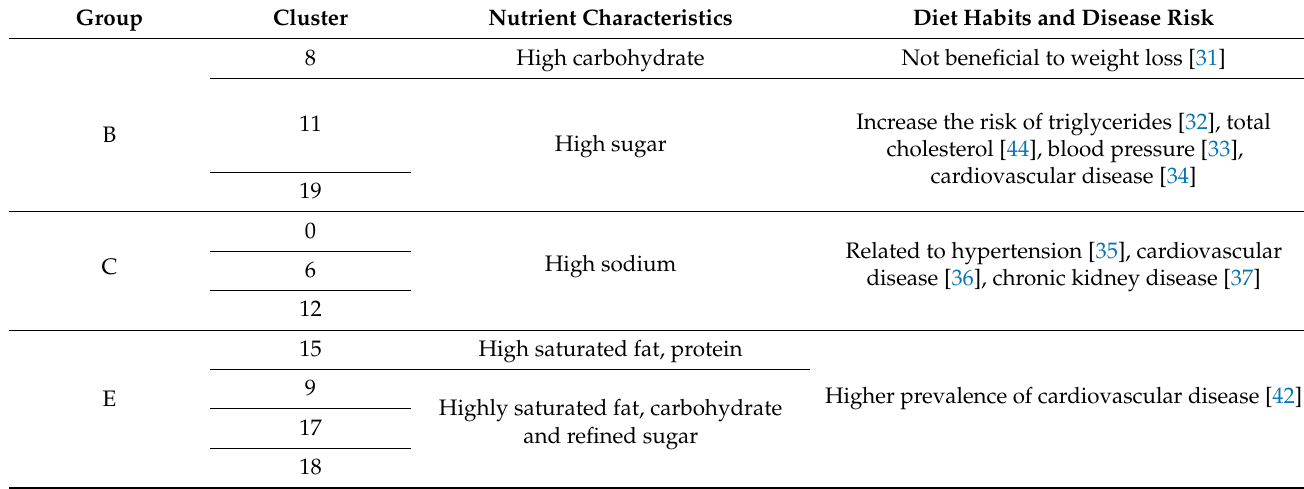
Table 11. Clusters and groups that do not conform with principles of healthy